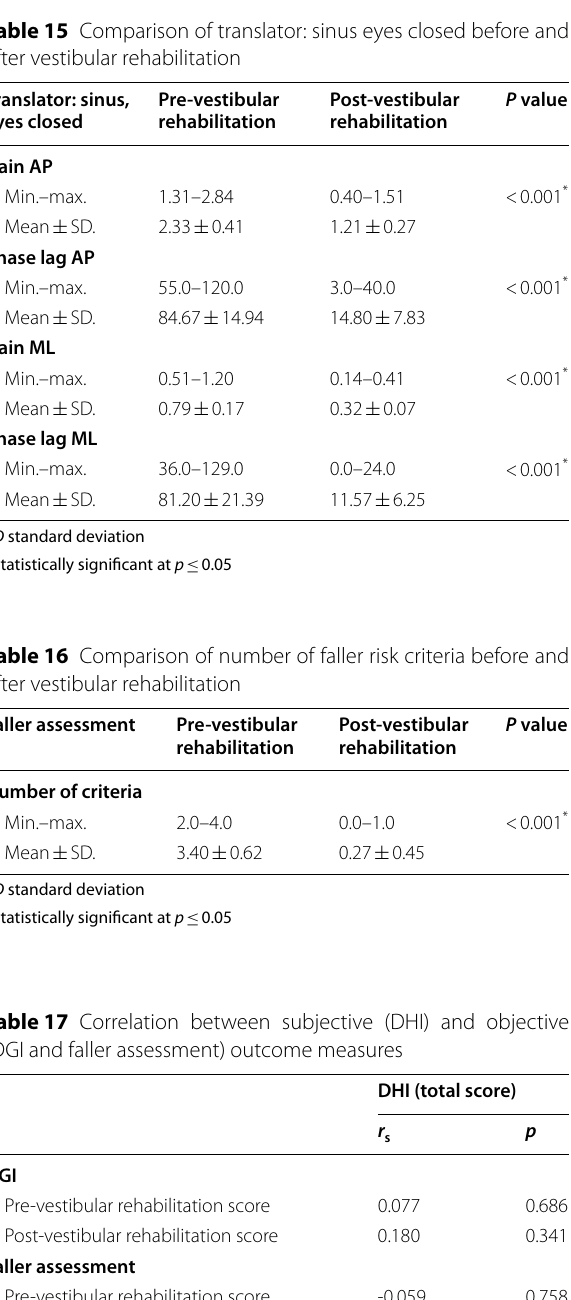
Table 15 Comparison of translator: sinus eyes closed before and after vestibular rehabilitation